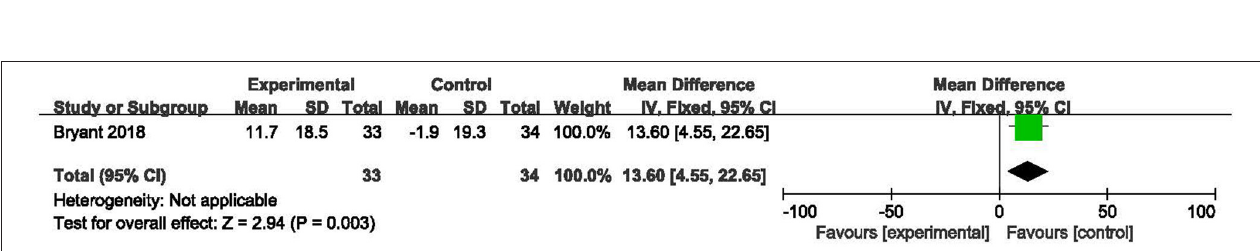
FIGURE 6 | Forest plot of network meta-analysis of the end-of-treatment effect on depression severity between cognitive behavioral therapy-brief and no treatment.